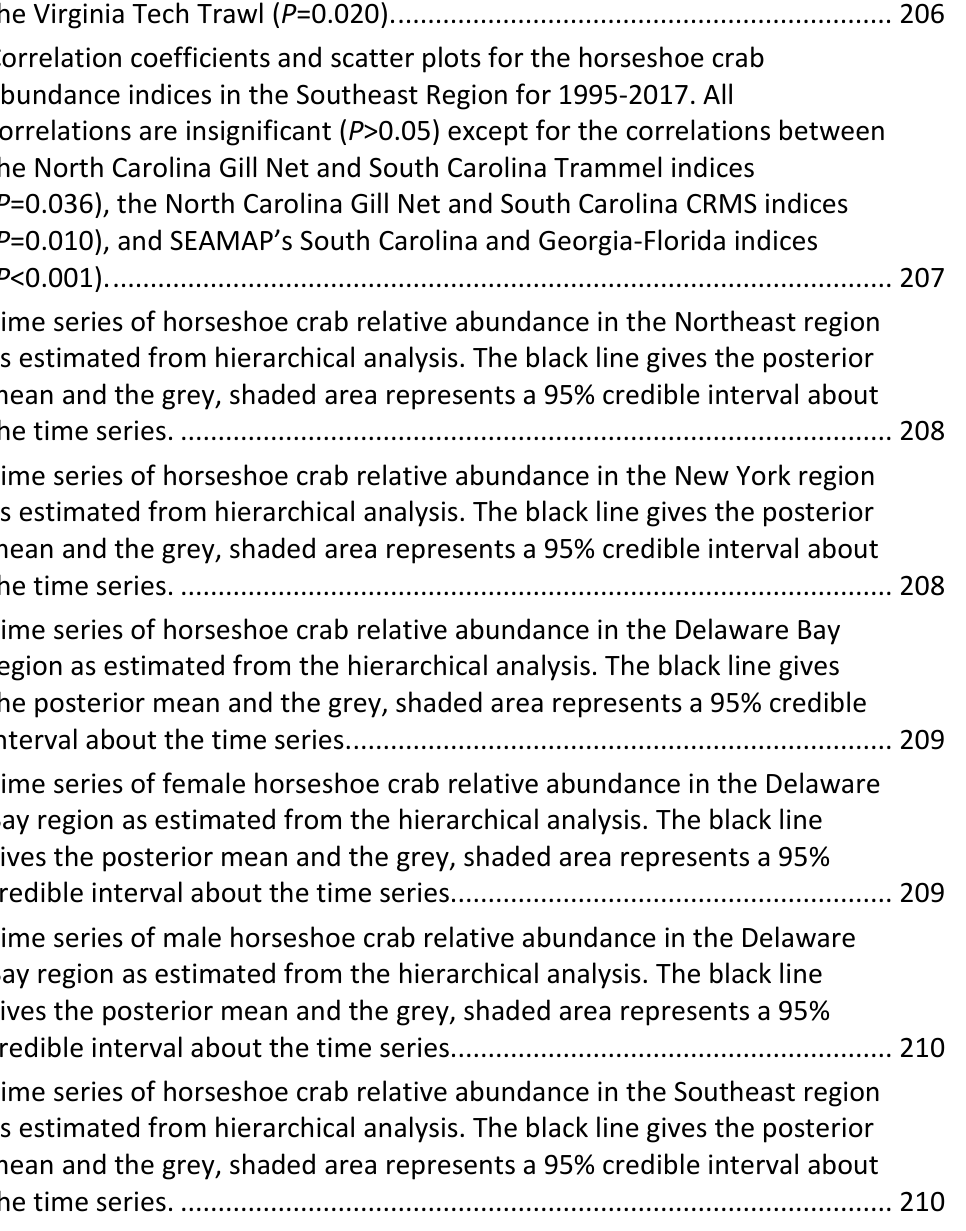
Figure 75. Correlation coefficients and scatter plots for the horseshoe crab abundance indices in the Delaware Bay Region for 1989-2017. All correlations are insignificant ( P >0.05) except for the correlations between the Delaware Adult Trawl spring and fall indices ( P <0.001), Delaware Adult Trawl spring and New Jersey Ocean Trawl fall ( P <0.001), New Jersey Ocean Trawl spring and Surf Clam surveys ( P =0.011), and NEAMAP and Figure 76. Correlation coefficients and scatter plots for the horseshoe crab abundance indices in the Southeast Region for 1995-2017. All correlations are insignificant ( P >0.05) except for the correlations between the North Carolina Gill Net and South Carolina Trammel indices ( P =0.036), the North Carolina Gill Net and South Carolina CRMS indices ( P =0.010), and SEAMAP’s South Carolina and Georgia-Florida indices Figure 77. Time series of horseshoe crab relative abundance in the Northeast region as estimated from hierarchical analysis. The black line gives the posterior mean and the grey, shaded area represents a 95% credible interval about Figure 78. Time series of horseshoe crab relative abundance in the New York region as estimated from hierarchical analysis. The black line gives the posterior mean and the grey, shaded area represents a 95% credible interval about Figure 79. Time series of horseshoe crab relative abundance in the Delaware Bay region as estimated from the hierarchical analysis. The black line gives the posterior mean and the grey, shaded area represents a 95% credible Figure 80. Time series of female horseshoe crab relative abundance in the Delaware Bay region as estimated from the hierarchical analysis. The black line gives the posterior mean and the grey, shaded area represents a 95% Figure 81. Time series of male horseshoe crab relative abundance in the Delaware Bay region as estimated from the hierarchical analysis. The black line gives the posterior mean and the grey, shaded area represents a 95% Figure 82. Time series of horseshoe crab relative abundance in the Southeast region as estimated from hierarchical analysis. The black line gives the posterior mean and the grey, shaded area represents a 95% credible interval